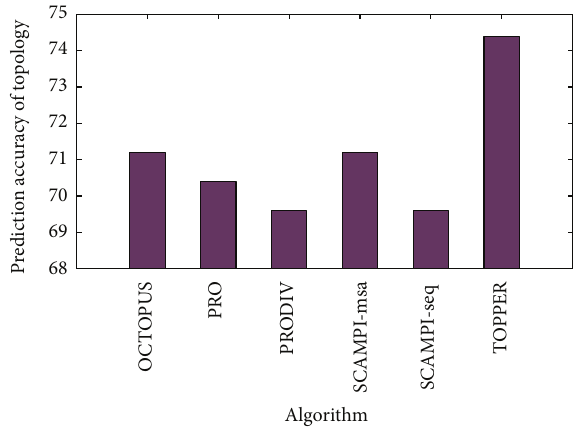
F 4: e comparison of F score between the proposed method and other algorithms.